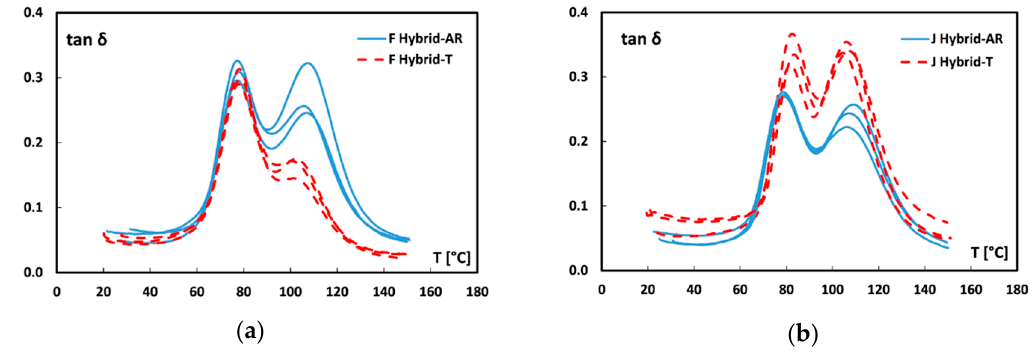
Figure 7. Damping factor curves of ( a ) flax hybrid and ( b ) jute hybrid laminates.